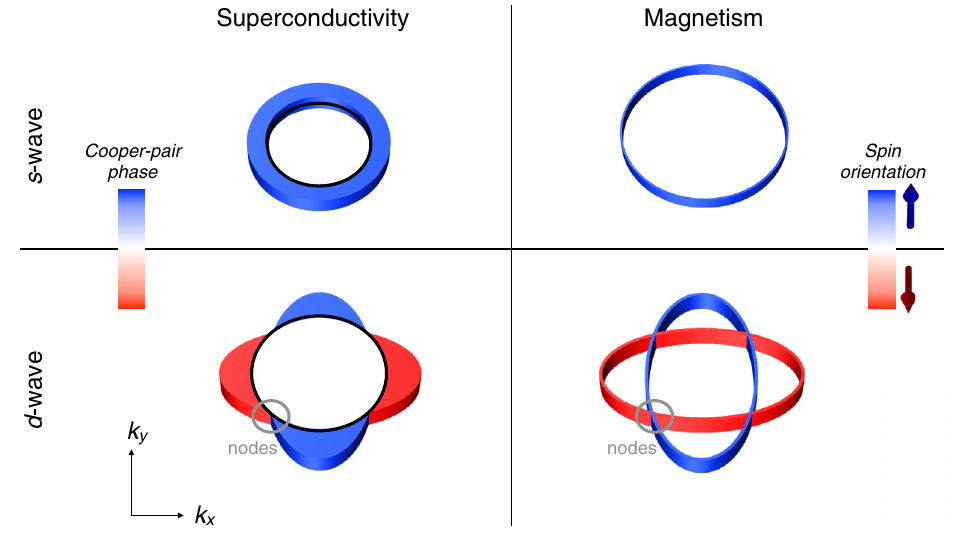
FIG. 2. Analogy between superconductivity and magnetism. Top: conventional s -wave superconductivity, which has the same Cooper-pair phase around the Fermi surface and is analogous to conventional magnetism (ferromagnetism) with an excess of one spin orientation around the Fermi surface. Bottom: unconventional d -wave superconductivity where the Cooper-pair phase changes sign around the Fermi surface, and the anticipated analogy of unconventional d -wave magnetism where the excess spin orientation changes sign around the Fermi surface. The unconventional phases have the characteristic nodes highlighted by gray circles. This figure was inspired by Ref. [29].